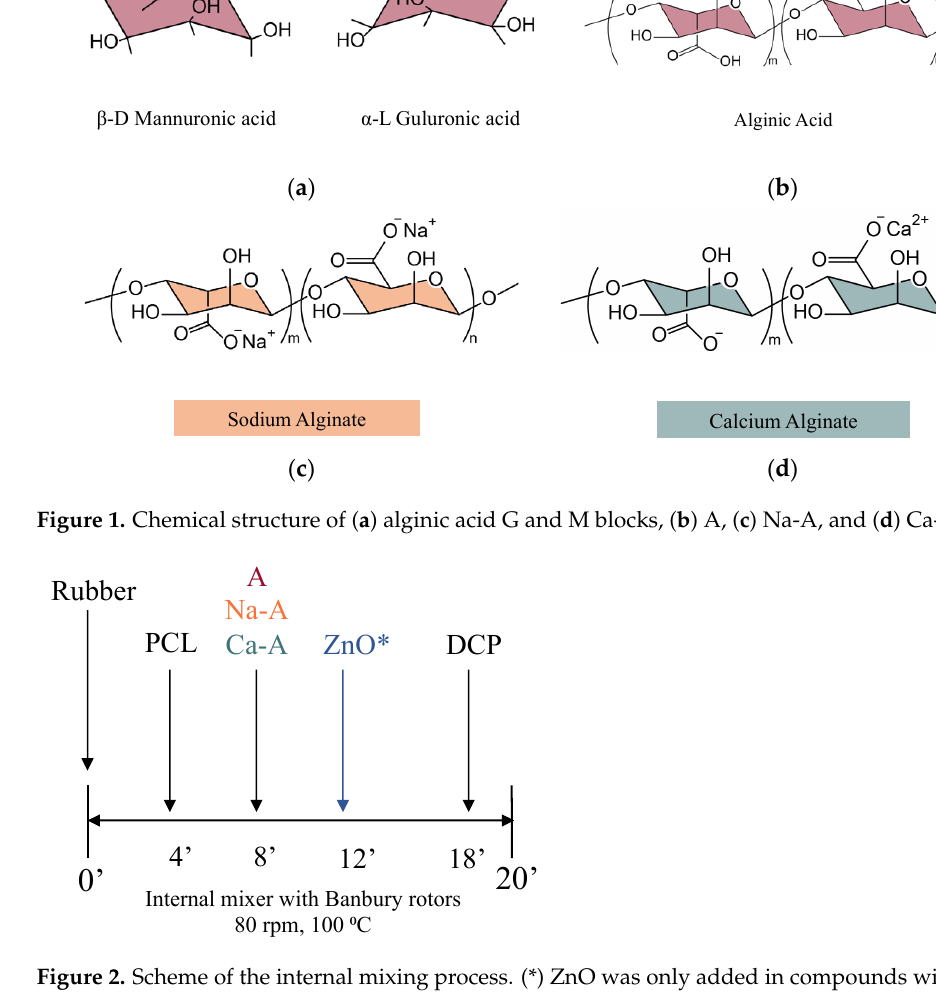
Figure 2. Scheme of the internal mixing process. (*) ZnO was only added in compounds with A.